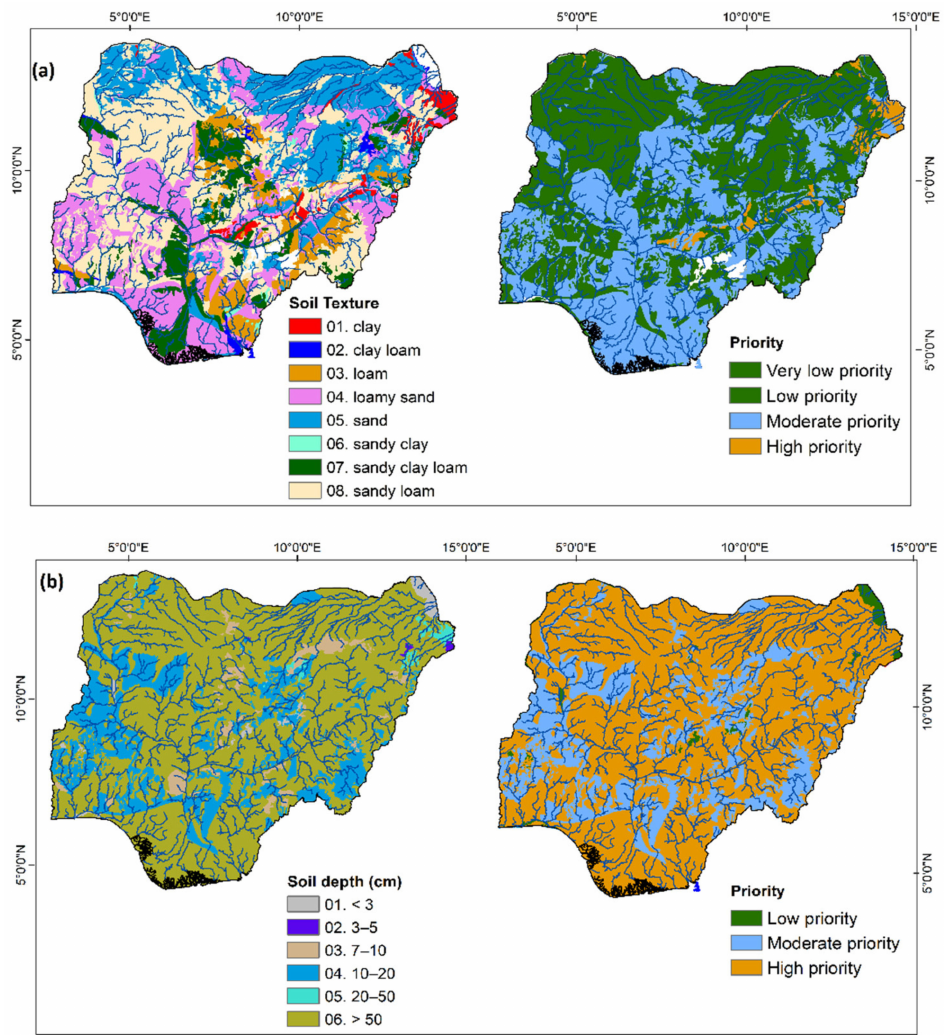
Figure 5. ( a ) Soil texture and its priority map and ( b ) soil depth and its priority